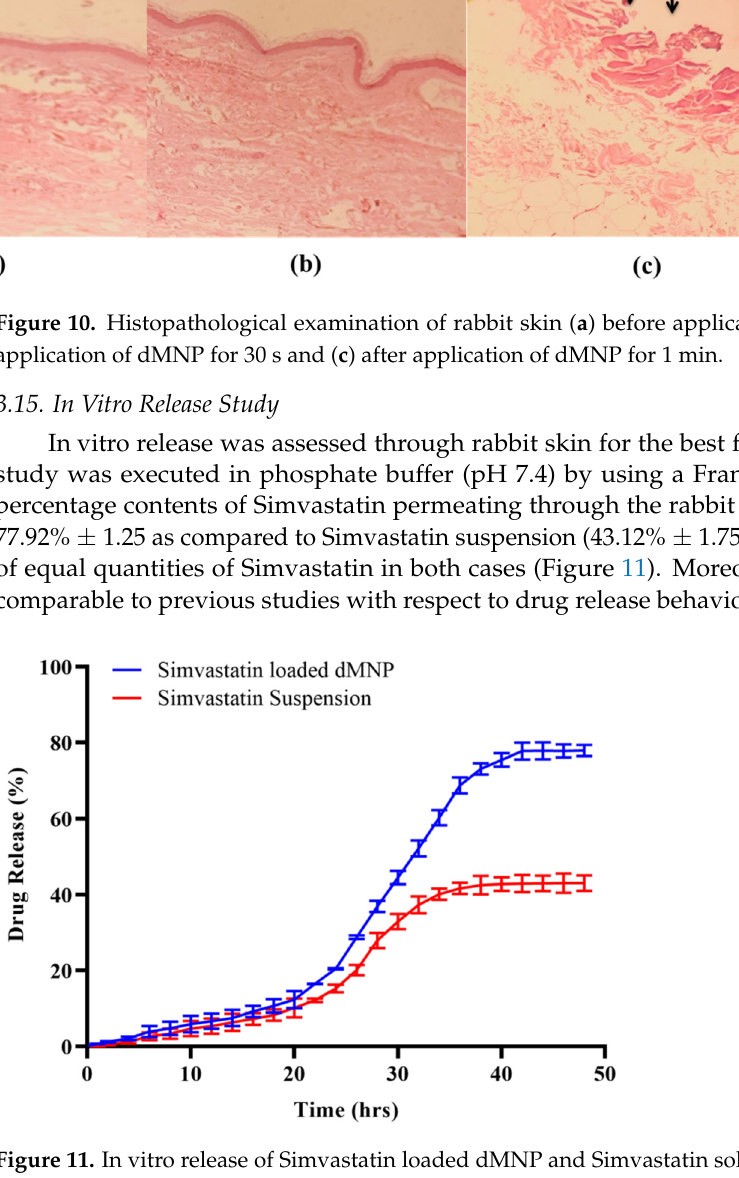
Figure 11. In vitro release of Simvastatin loaded dMNP and Simvastatin solution at pH 7.4. Table 4. Release results of reported